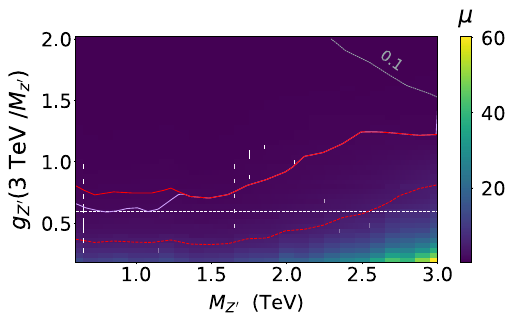
Fig. 7 μ for the ATLAS di-muon search [52] at each point in the Fig. 9 μ for the b -veto category of the ATLAS di-muon search [63] scanned parameter space. The solid red line shows the contour μ = 1. at each point in the scanned parameter space. The solid red line shows The area above this is excluded at the 95% CL. The dashed red line the contour μ = 1. The area above this is excluded at the 95% CL. shows our estimate of the HL-LHC sensitivity. The solid purple line The dashed red line shows our estimate of the HL-LHC sensitivity. The shows the current observed bound from all searches considered in this solid purple line shows the current observed bound from all searches work. The dashed grey line shows the contour where (cid:10)/ M Z (cid:2) = 0 . 1 , considered in this work. The dashed grey line shows the contour where and the region between the dashed white line and the bottom of the plot (cid:10)/ M = 0 . 1 , and the region between the dashed white line and the Z (cid:2) is favoured by the flavour and electroweak data at the 95% CL. Toward bottom of the plot is favoured by the flavour and electroweak data at the the extreme left-hand side of the plot, our predictions become more 95% CL. Toward the extreme left-hand side of the plot, our predictions / M 2 ) relative corrections inaccurate due to unaccounted-for O ( M 2 become more inaccurate due to unaccounted-for O ( M 2 Z Z (cid:2) corrections